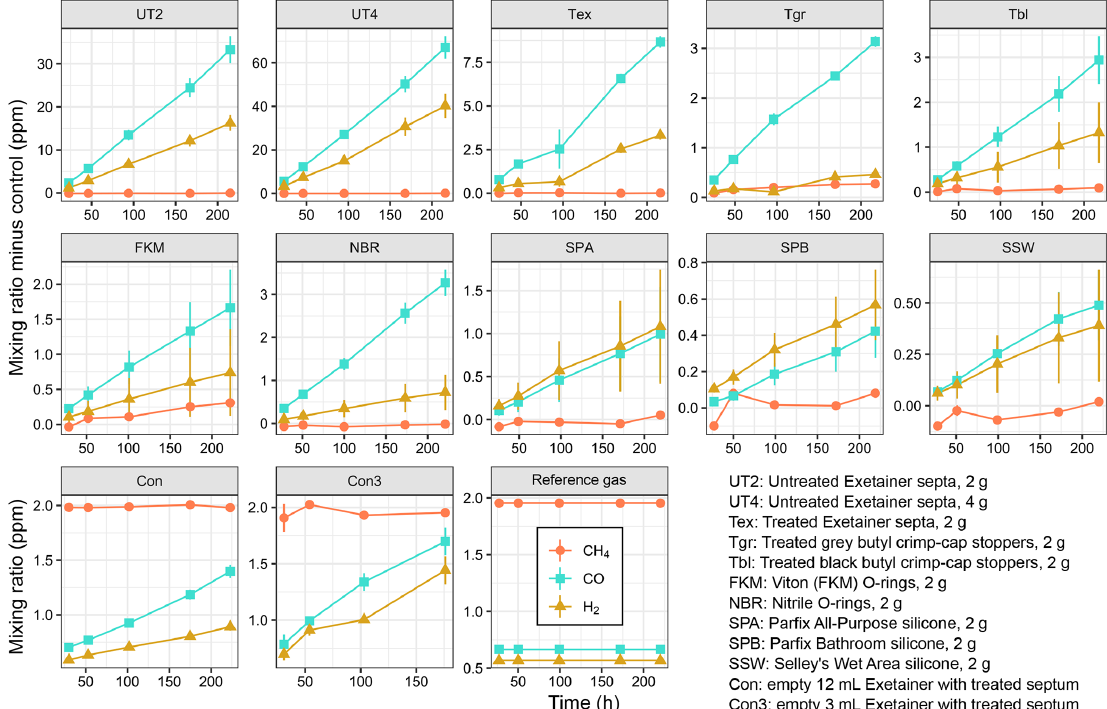
Figure 2. Dihydrogen (H 2 ), carbon monoxide (CO) and methane (CH 4 ) released from various sealing rubbers and corrected for release in empty control vials. Replicate samples ( n = 4) of 2 or 4g of rubber material were prepared in 12mL Exetainers sealed with a treated Exetainer septum and flushed with pressurised air as a reference gas. Controls consisted of empty Exetainers ( n = 6) sealed with a treated Exetainer septum. Samples were measured repeatedly except for Con3 samples where n = 3 replicates were sacrificed for each measurement due to low gas volume. Error bars denote standard error of the mean. Please note the different scales of the y